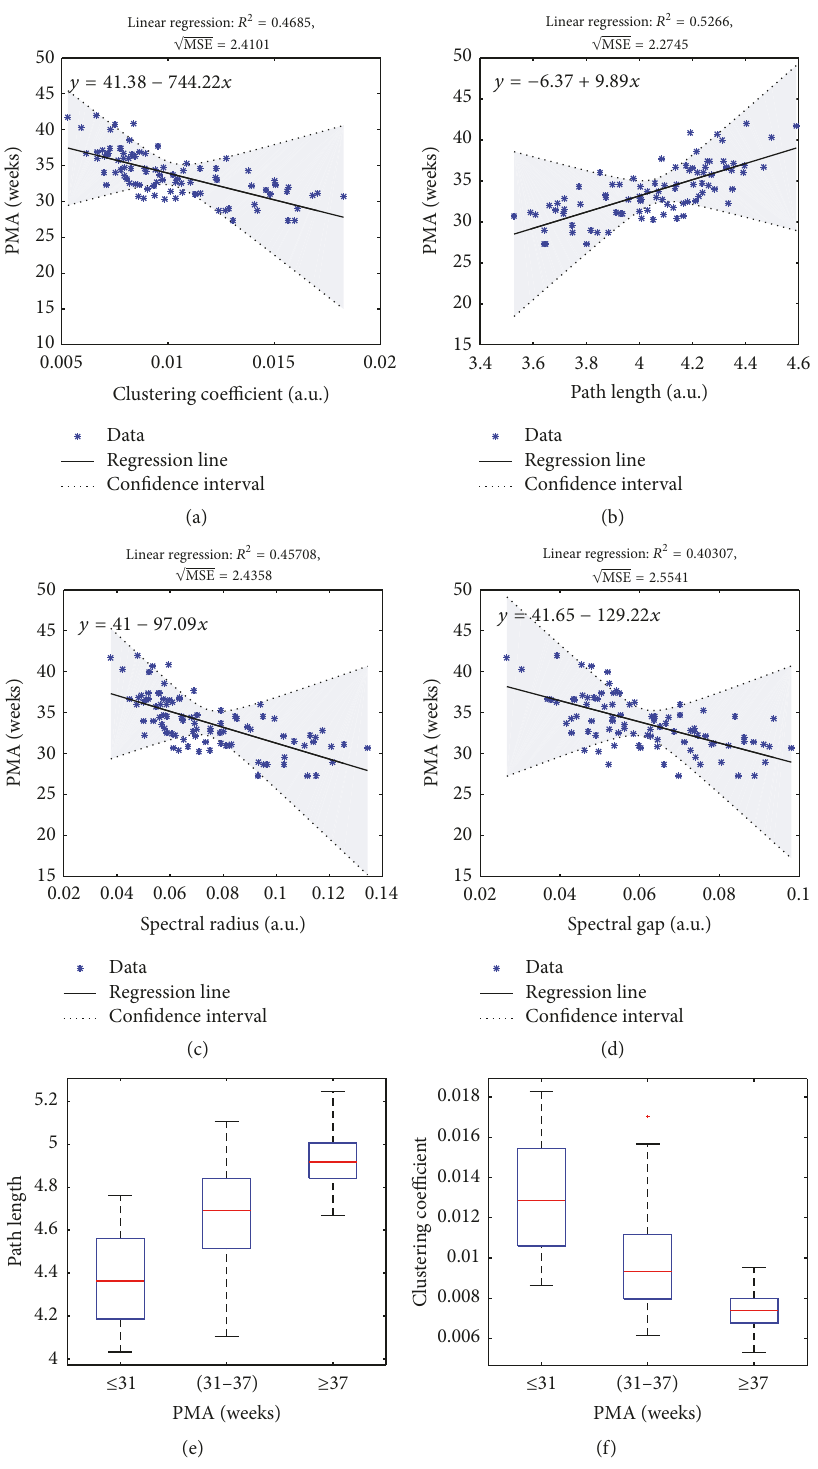
Figure 3: The figure shows the results for EEG data. (a, b, c, d) show OLS regression between 4 main graph indices versus the age (PMA in weeks) for GC in QS. The grey area is the confidence interval at 95 %. On the top of the panel, the associated 𝑅 2 and √ MSE in PMA weeks on the test set. (e, f) show the trend of the clustering coefficient and the path length in three distinct age groups. The results are reported about GC in